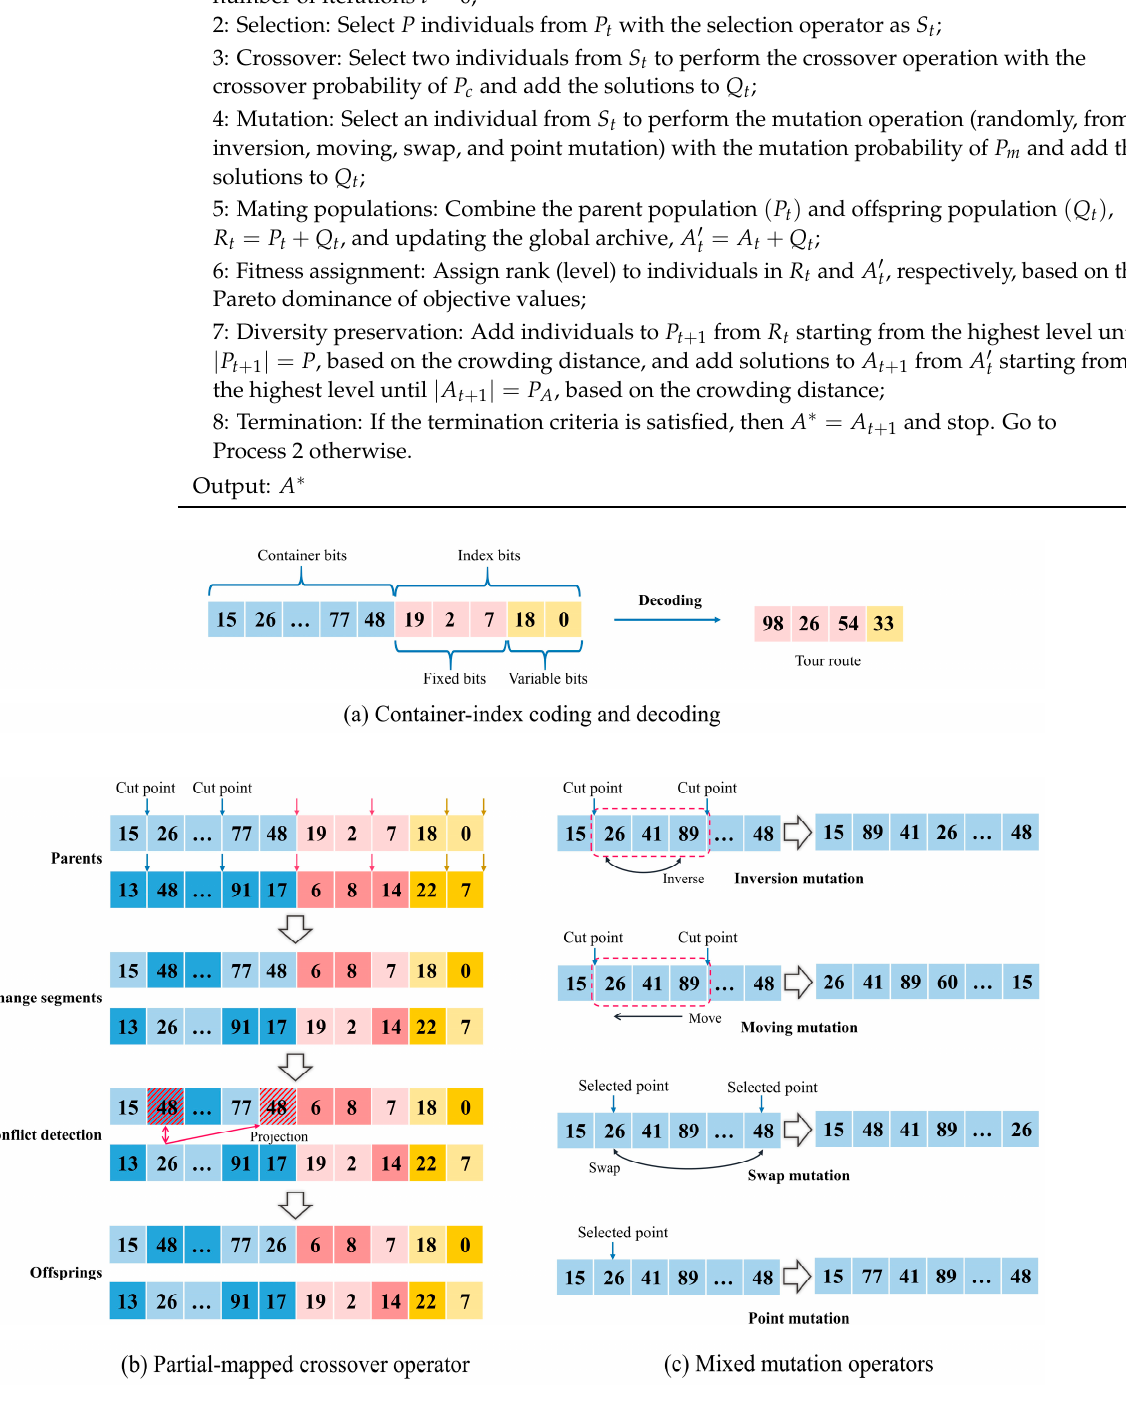
Figure 4. Representation of the chromosome and evolutionary operators: ( a ) container-index coding and decoding; ( b ) partial-mapped crossover operator; ( c ) mixed mutation operators.